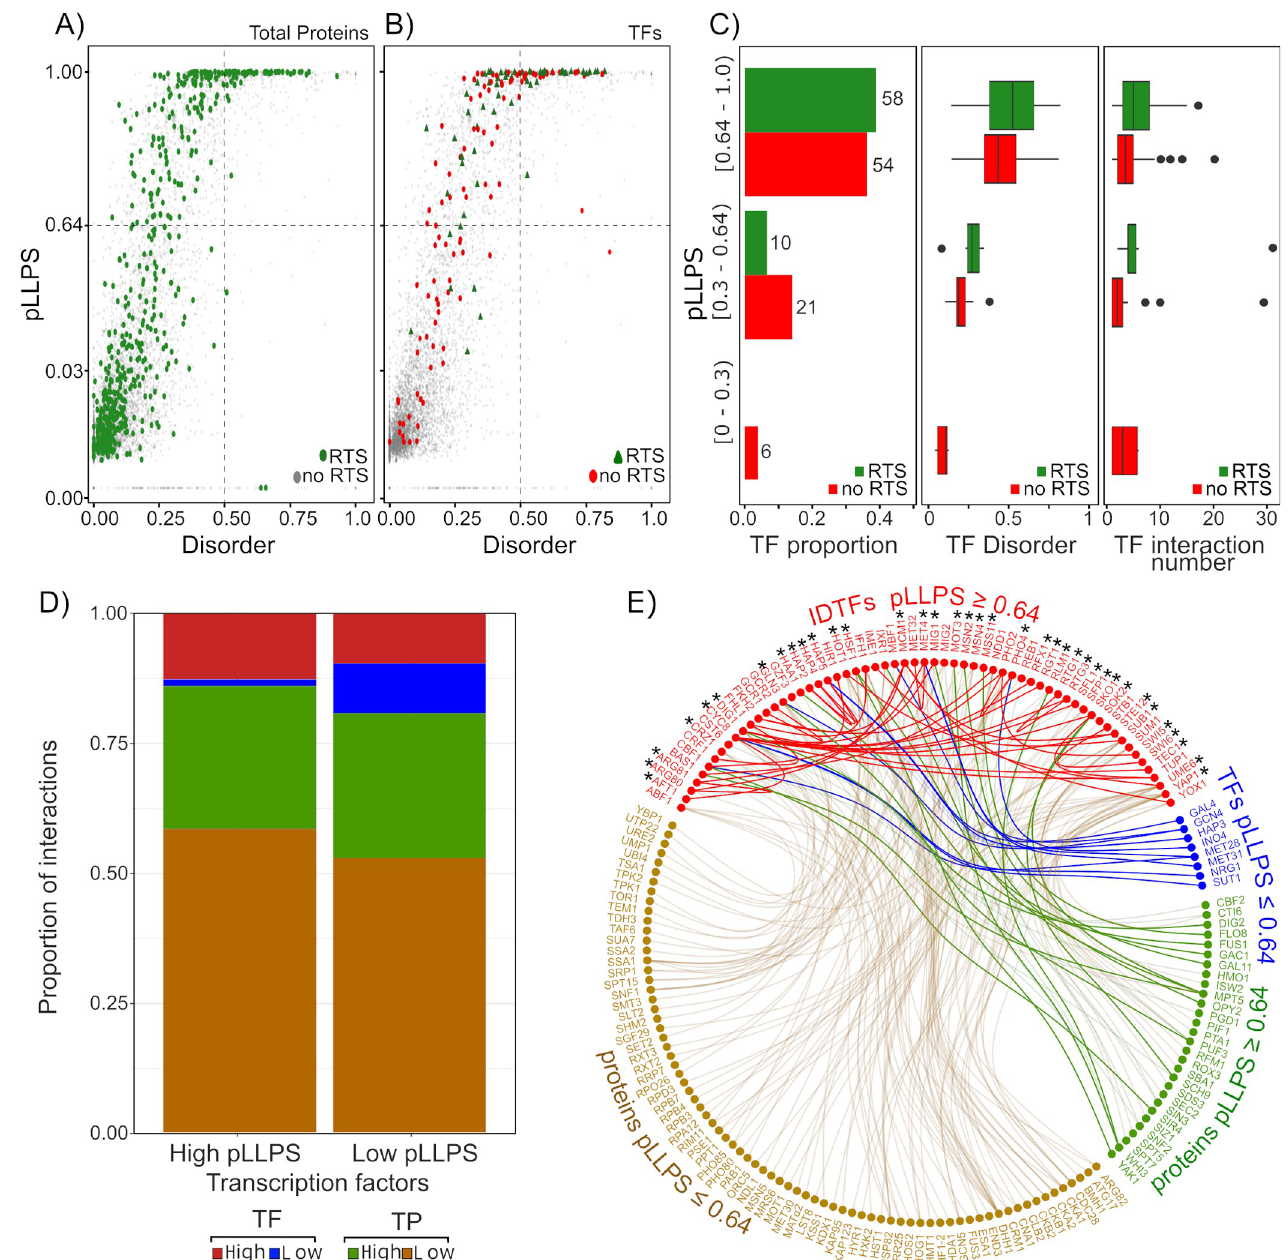
Fig 7. Liquid-Liquid Phase Separation (LLPS) propensity of yeast TFs. LLPS probability index (pLLPS) was determined using FuzPred, and disorder probability index was obtained using MobiDB. (A) Relation between pLLPS index and disorder ratio of the complete yeast proteome (light grey circles). Green circles represent proteins related to stress responses (RTS). Vertical and horizontal discontinue gray lines represent the cutoff values for disorder ratio ( � 0.5) and for pLLPs ( � 0.64), respectively. (B) Relation between pLLPS index and disorder ratio for TFs. Red circles and green triangles represent TFs no related to stress (no RTS) and RTS, respectively. (C) Distribution of TFs considering their pLLPS index, and its relation to their disorder ratio, number of interactions and participation in stress responses. (D) Interaction proportion for TFs according to their pLLPS index. Interaction proportions between TFs with high ( � 0.64) and with low pLLPS ( � 0.64) are represented in red and blue blocks, respectively, whereas proportions between TFs and proteins (TP) with high pLLPS ( � 0.64) and low pLLPS ( � 0.64) are represented with green and brown blocks, respectively. (E) Interaction network for IDTFs with pLLPS � 0.64 (in red) with: TFs showing pLLPS � 0.64 (in blue), proteins with pLLPS � 0.64 (in brown) and proteins with pLLPS � 0.64 (in green). IDTFs related to stress are indicated with an asterisk. The connector lines colour corresponds to the pLLPS index of the corresponding interactor.